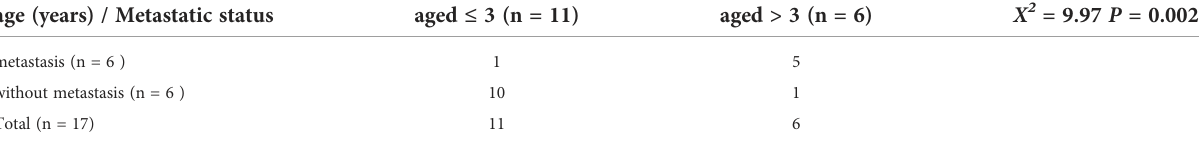
TABLE 4 Correlations between metastatic status and age in